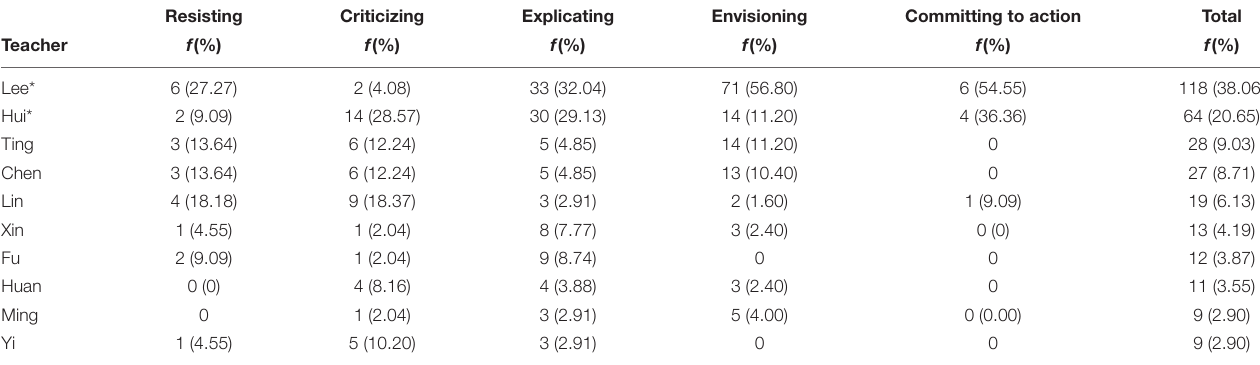
TABLE 4 | The number of transformative agency expressions for different